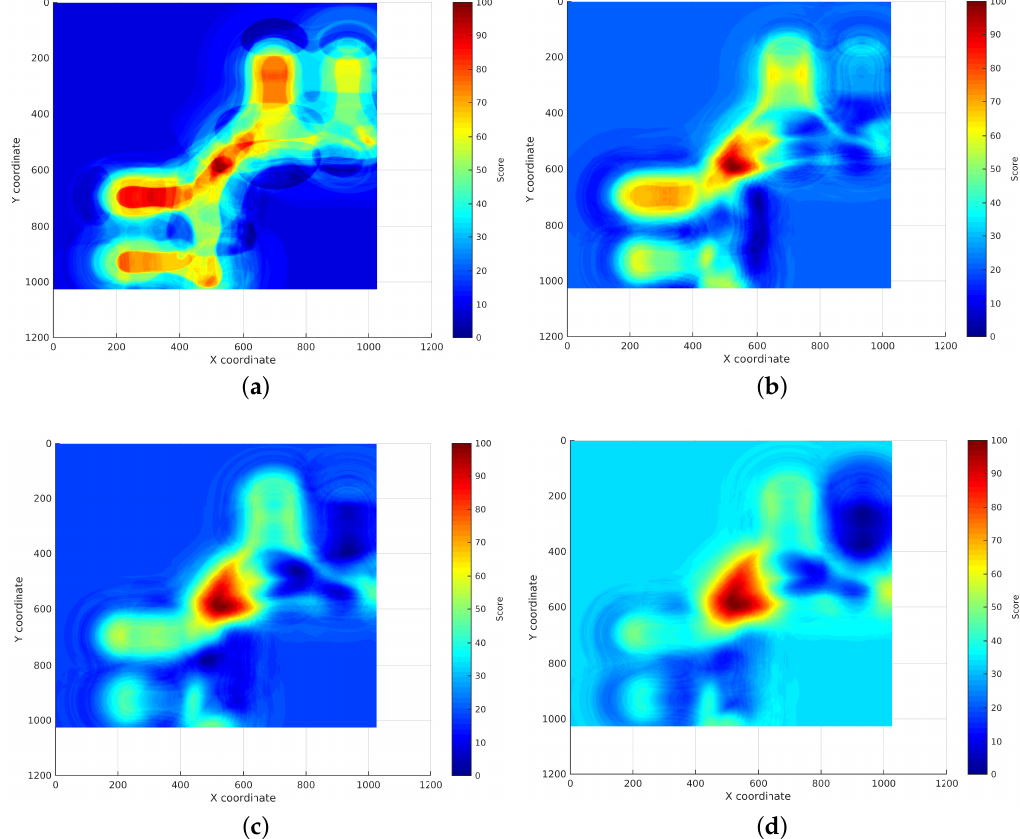
Figure 12. Localization subsurfaces created using different noise margins. ( a ) Margin 1; ( b ) Margin 5; ( c ) Margin 10; ( d ) Margin